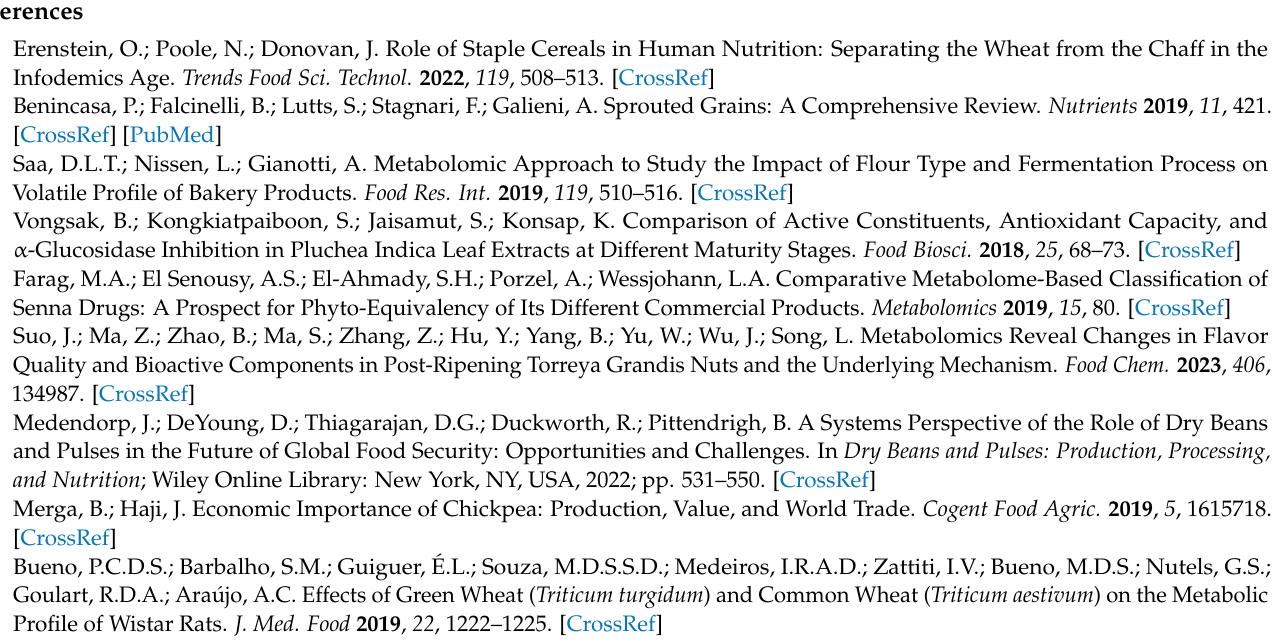
OPLS-DA score plot (A) derived from modelling silylated primary metabolites of all mature samples against all immature ones ( n = 3). The respective loading S-plots (B) shows the covariance p[1] against the correlation p(cor)[1] of the variables of the discriminating component of the OPLS-DA model.Cut-off values of p = 0.001was used. Designated variables are highlighted and identifications are discussed in the text; Figure S3: GC/MS based OPLS-DA score plot (A) derived from modelling silylated primary metabolites of mature vs. immature T. aestivum (cv. Gemeza 11 ) specimens ( n = 3). The respective loading S-plots (B) shows the covariance p[1] against the correlation p(cor)[1] of the variables of the discriminating component of the OPLS-DA model. Cut-off values of p = 0.09 was used. Designated variables are highlighted and identifications are discussed in the text; Figure S4: GC/MS based OPLS-DA score plot (A) derived from modelling silylated primary metabolites of mature vs. immature V. faba (cv. Sakha 3 ) specimens ( n = 3). The respective loading S-plots (B) shows the covariance p[1] against the correlation p(cor)[1] of the variables of the discriminating component of the OPLS-DA model. Cut-off values of p = 0.06 was used. Designated variables are highlighted and identifications are discussed in the text; Figure S5: A bar graph showing diagrammatic values of the protein % ( w / w ) of both immature and mature seeds side by side. Each bar represents mean ± SE ( n = 3); Table S1: A summary of the total protein assay results, showing the nitrogen (% w / w ) of each sample, as well as the protein ( w / w ) after factor conversion. All results are expressed as mean ± SD, ( n =